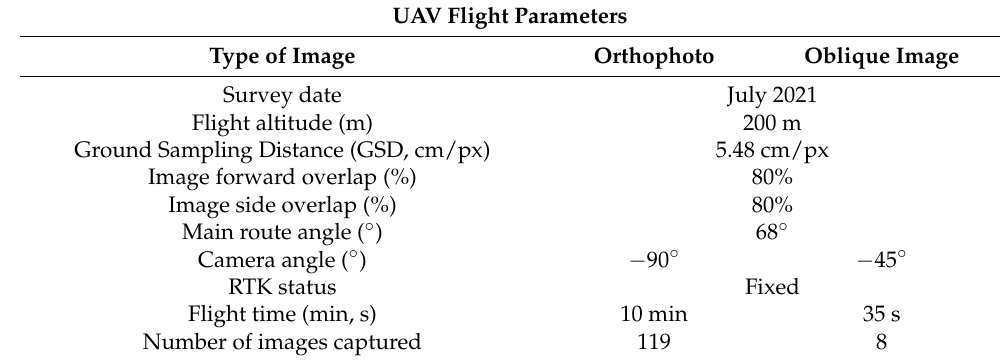
Table 2. UAV flight parameters.